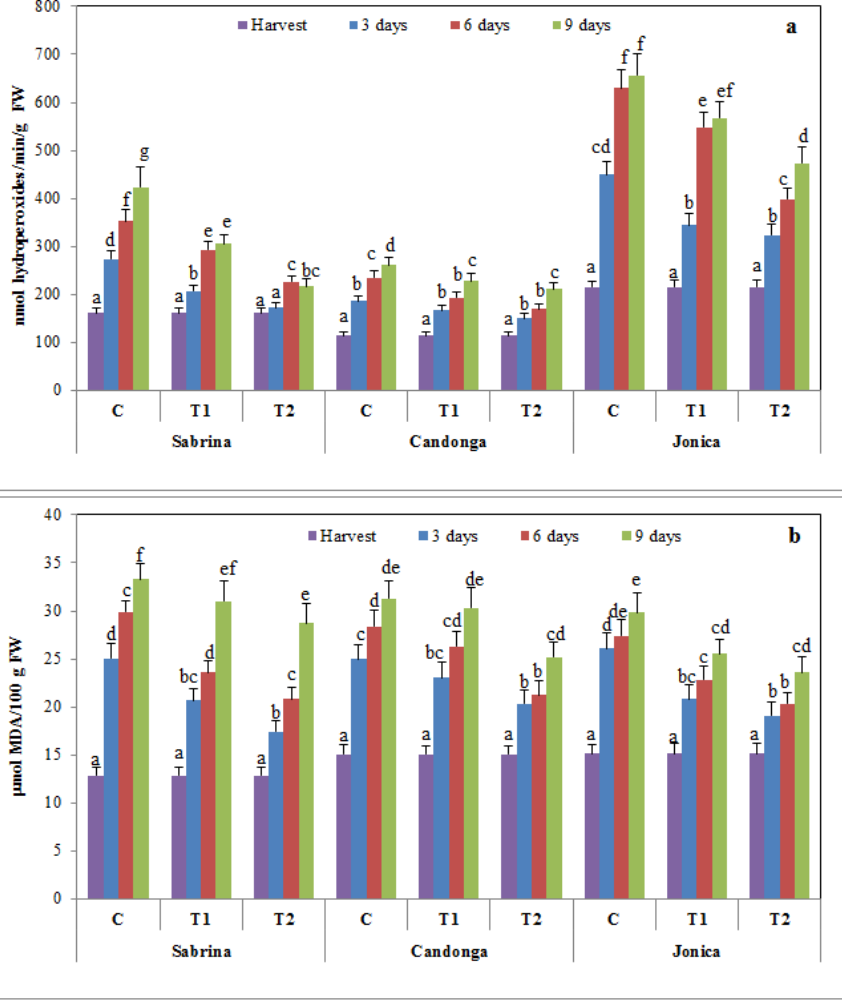
Figure 6. Changes in lipoxygenase activity (LOX) ( a ) and malondialdehyde content (MDA) ( b ) of strawberry cultivars during cold storage at 2 °C for nine days (error bars indicate standard